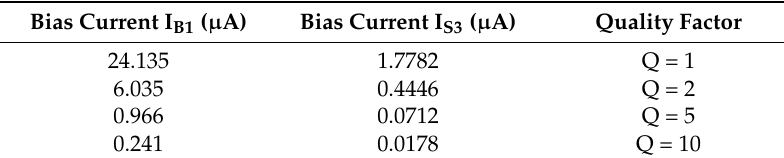
Figure 10. The VM bandpass filter at the output V o2 of Figure 2 when variation in Q with f o fixed at 3.183 MHz (Q = 1: blue; Q = 2: red; Q = 5: green; and Q = 10: pink). Table 7. The different I B1 and I S3 values used to obtain a specified Q .